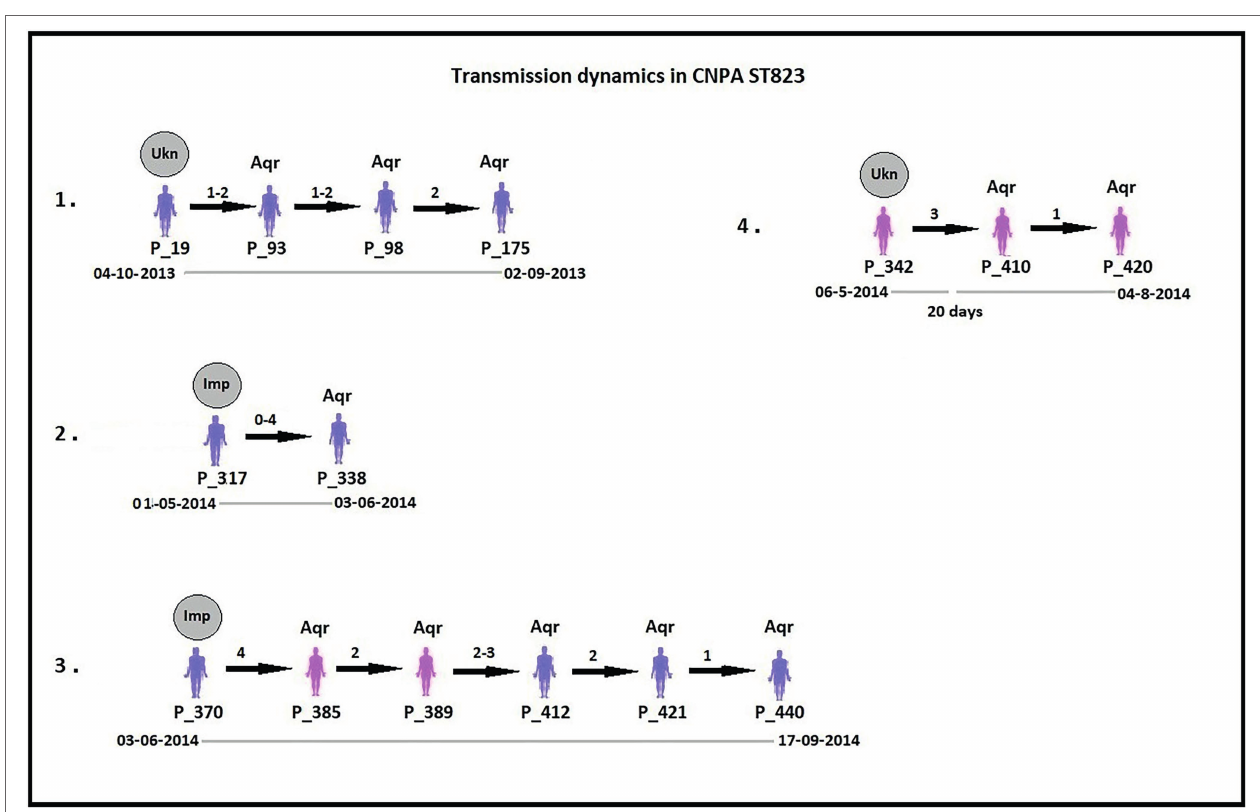
FIGURE 8 | Potential transmissions of CNPA ST823 isolates among the patients (their ID given as “P_”). Pink colored patients are from adult-ICU and purple colored patients are from ER-ICU. Strain relatedness in terms of pairwise wgSNP distances (0–4) among the strains is shown on the respective arrow between the two patients harboring strains associated with the transmission event. In some patients, more than one isolate was collected, therefore the pairwise wgSNP distances have a range between the two patients. All these transmissions are arranged in ascending order according to their time of admission to the ICU and their sample collection date from the year 2013 to 2015. The gray circle above first patient in each transmission event denotes that CNPA strain either imported (if labeled as “Imp”) from outside at the time admission or acquired from unknown (if labeled as “Ukn”) source within the ICU. Other patients in each transmission chain labeled as “Aqr” which means they acquired these clones during hospitalization. Hospitalization time line of the patients is shown below each transmission chain. The gap in the time line depicts that there is a time difference between discharge of one patient and admission of another to the